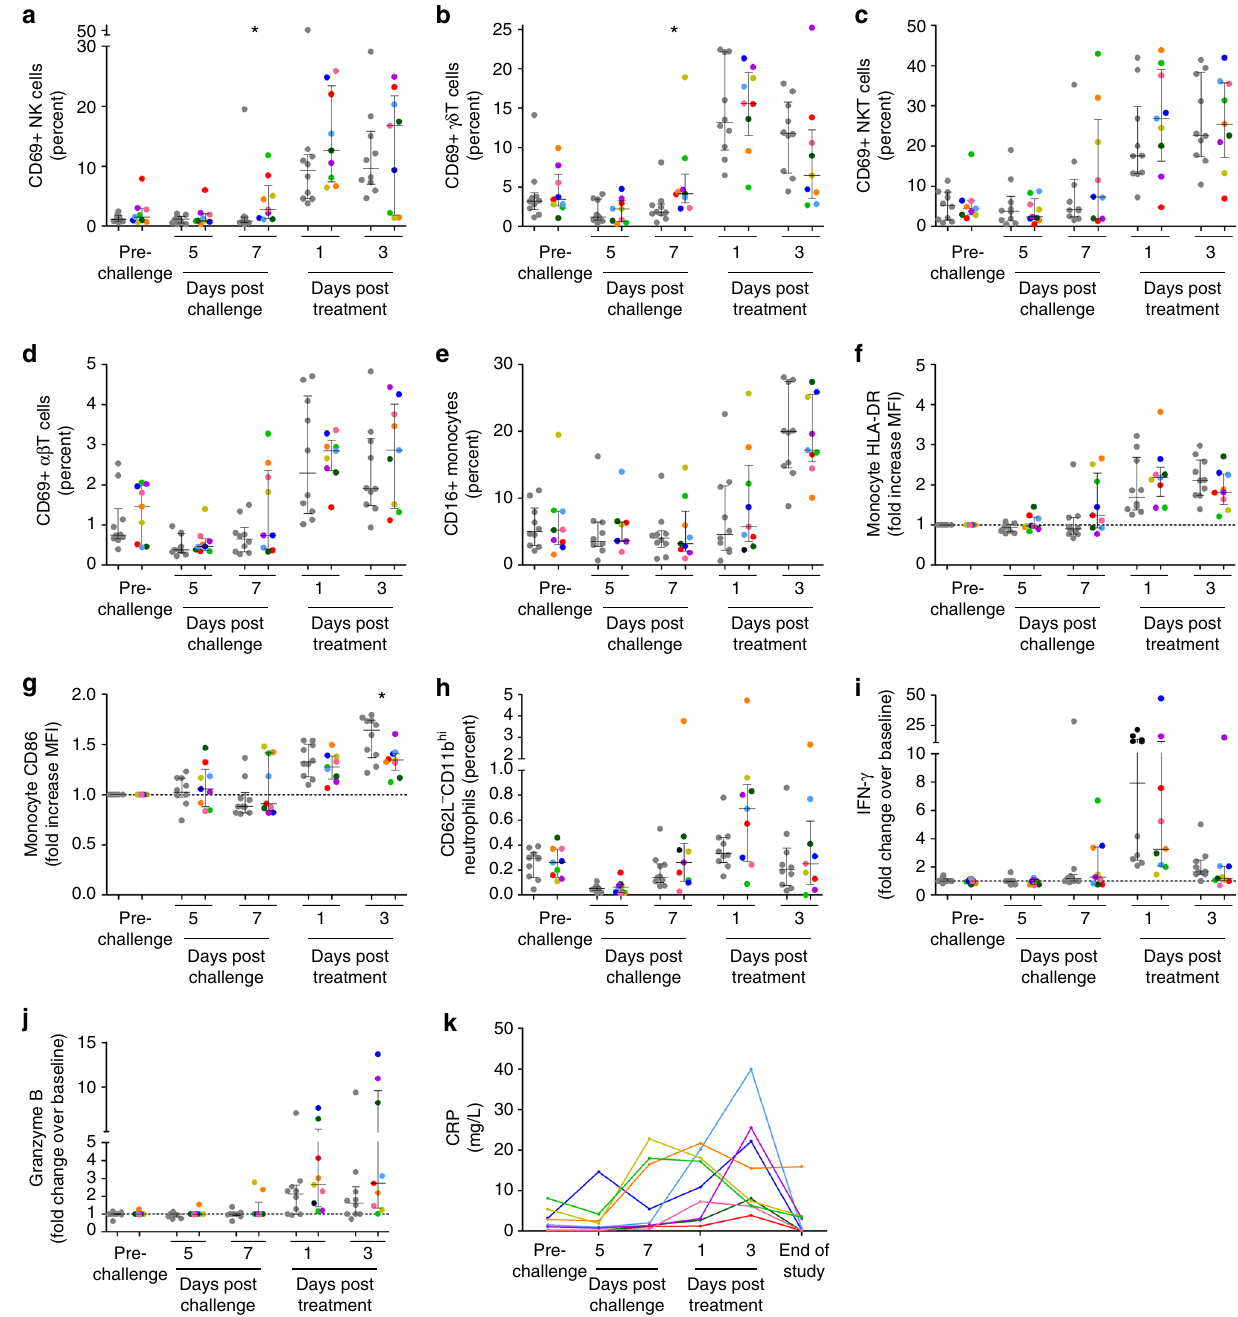
Fig. 2 In vivo activation of lymphocytes, monocytes and neutrophils after CHMI. In vivo leucocyte activation was determined by direct staining of